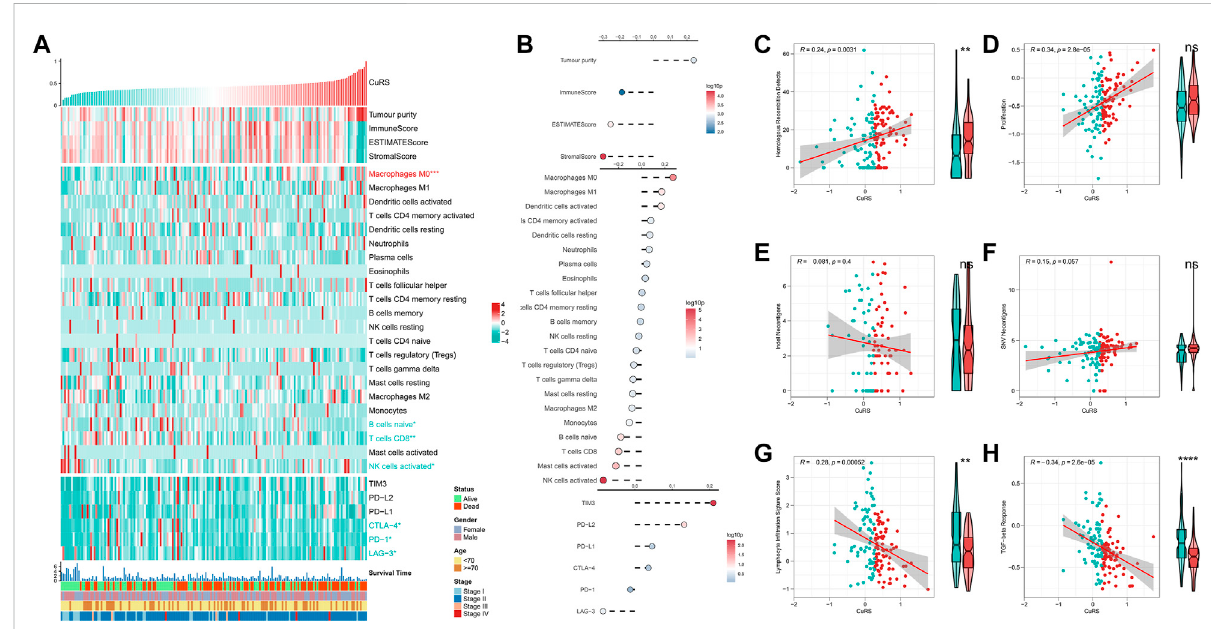
FIGURE 5 Immune landscape in the CuRS model. (A) Heat map showing the correlation between CuRS, estimate score, immune cell in fi ltration abundances, immune checkpoint expression, and clinical characteristics; (B) From top to bottom: correlation analysis for CuRS with estimate score, immune cell in fi ltration abundance, and immunecheckpoint expression; Scatter and box plots showing thecorrelation of CuRS with (C) HRD score, (D) proliferation score, (E) intratumor heterogeneity score, (F) SNV neoantigens, (G) lymphocyte in fi ltration score, and (H) TGF-beta